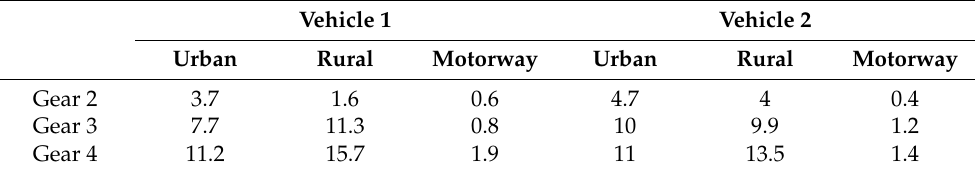
Table 5. Percentage share of trip time with lower than optimal gear selected.